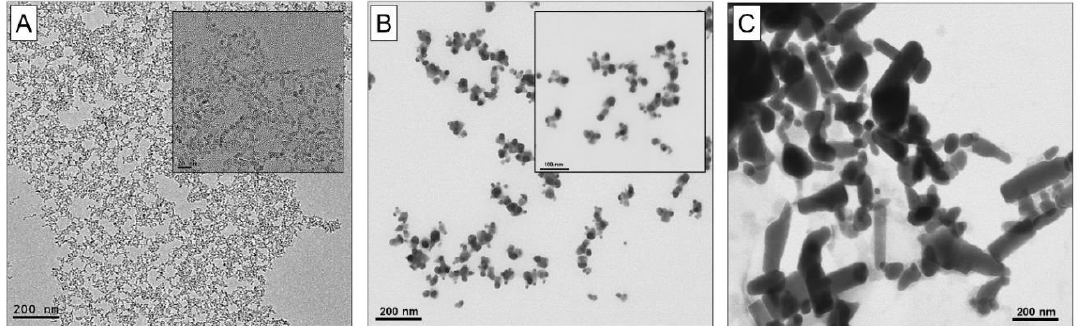
Figure 1. Representative transmission electron microscopy (TEM) images of ( A ) quasi-spherical TiO 2 -NPs, and representative scanning transmission electron microscopy (STEM) images of ( B ) spherical Ag-NPs and ( C ) irregular ZnO-NPs in pure water. Scale bar = 200 nm. Scale bar in inserts: ( A ) 20 nm and ( B ) 100